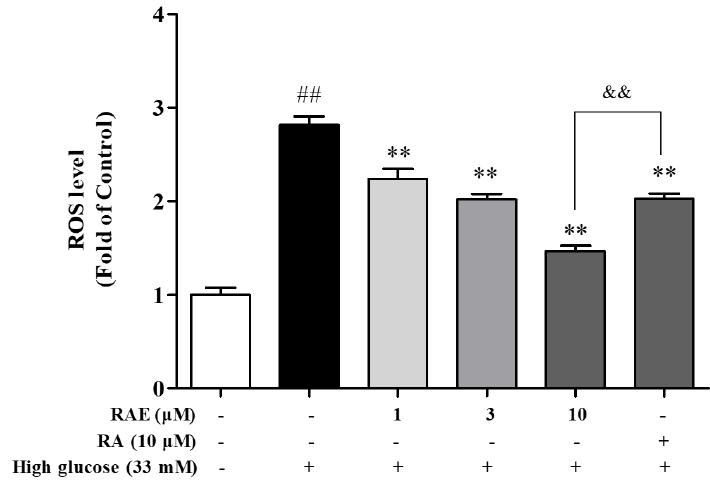
Figure 2. Effect of RAE on ROS generation in high glucose-induced human endothelial cells. EA.hy926 cells were co-treated with 33 mM of glucose and RAE or RA at different concentrations for 48 h. Intracellular ROS production was assessed by fluorescence of 2 (cid:48) ,7 (cid:48) -dichlorofluorescin diacetate (DCFH-DA), as described in methods. Results were expressed as mean ± SD (n = 3). ## P < 0.01, vs. control; ** P < 0.01, * P < 0.05, vs. high glucose; && P < 0.01, vs. RAE